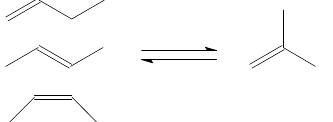
Figure 2. Skeletal isomerisation of n -butenes to isobutene.